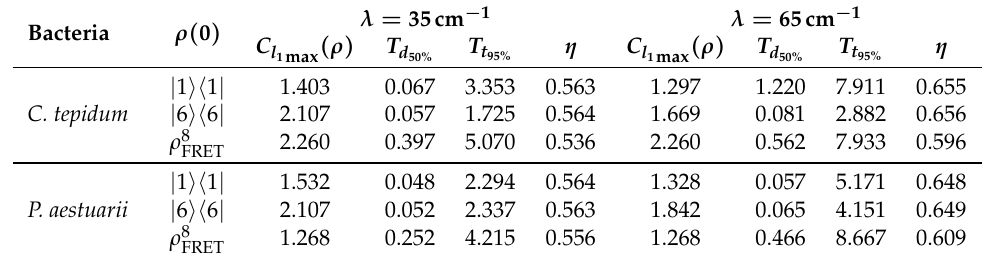
Table 2. Summary of featuring values for C. tepidum and P. aestuarii under several initial conditions